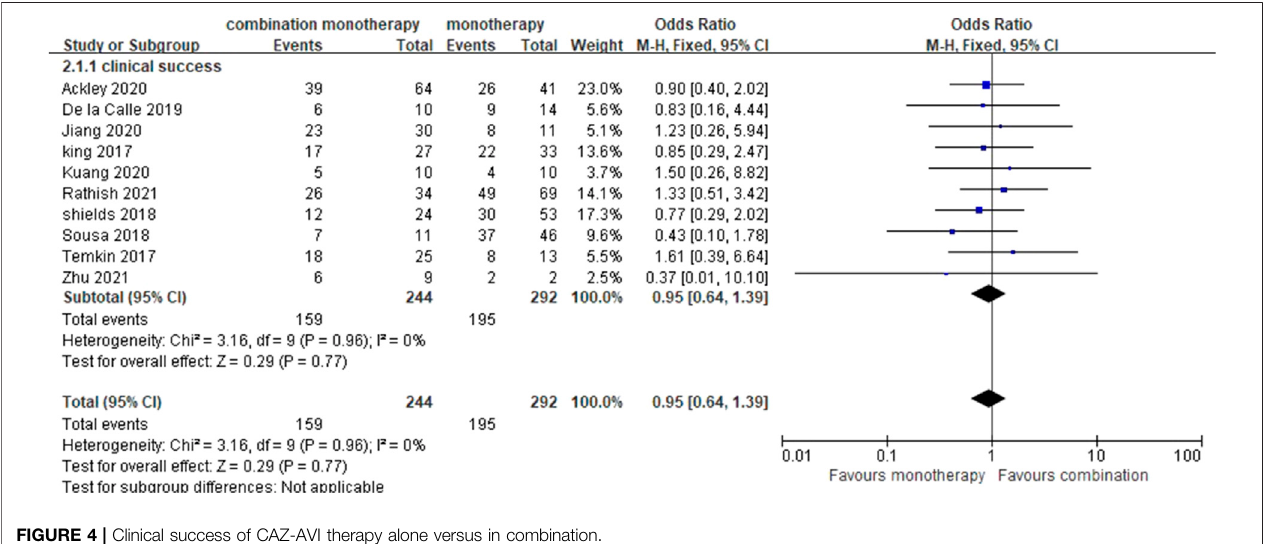
FIGURE 4 | Clinical success of CAZ-AVI therapy alone versus in combination.